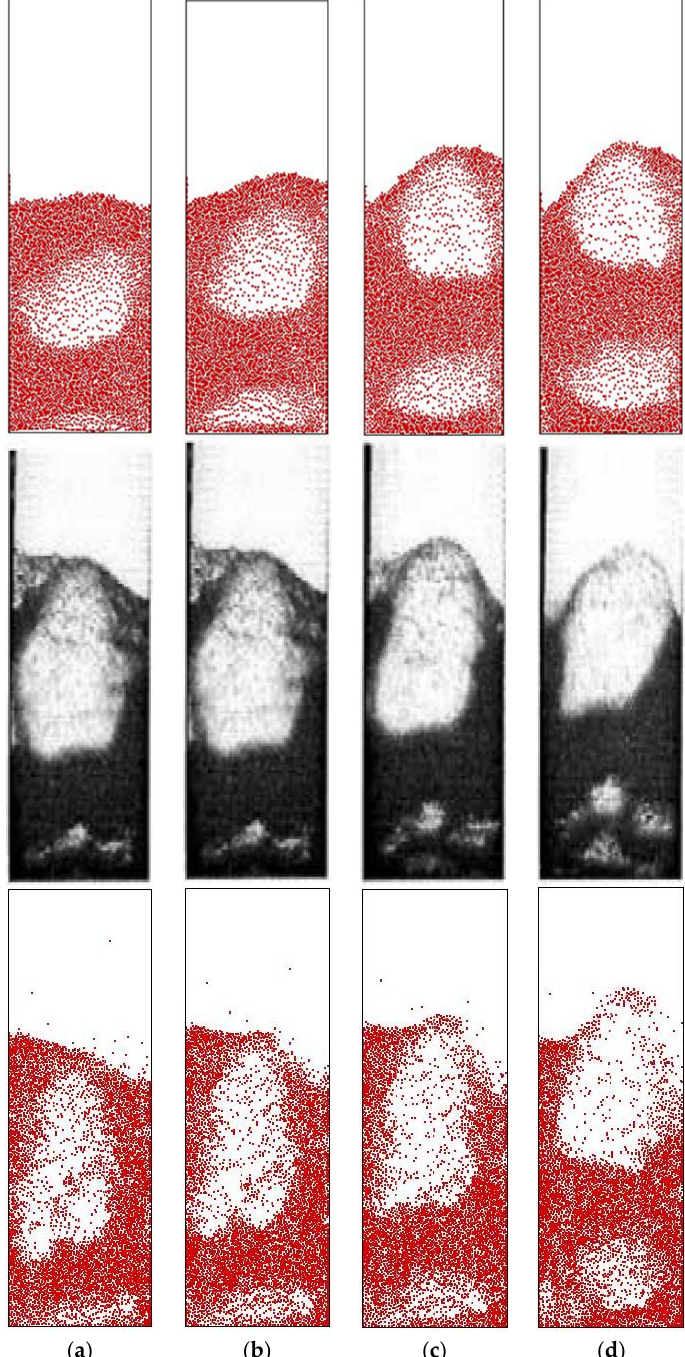
Figure 5. Snapshots of particle distribution in a two dimensional fluidized bed. Upper: simulation results obtained by the traditional coarse grain DEM-CFD method. Middle: experimental results given by Van Wachem et al. [18] (reused with permission from Elsevier). Bottom: simulation results obtained by the current dynamic coarse grain DEM-CFD method. ( a ) 0.16 s. ( b ) 0.20 s. ( c ) 0.24 s. ( d ) 0.28 s.